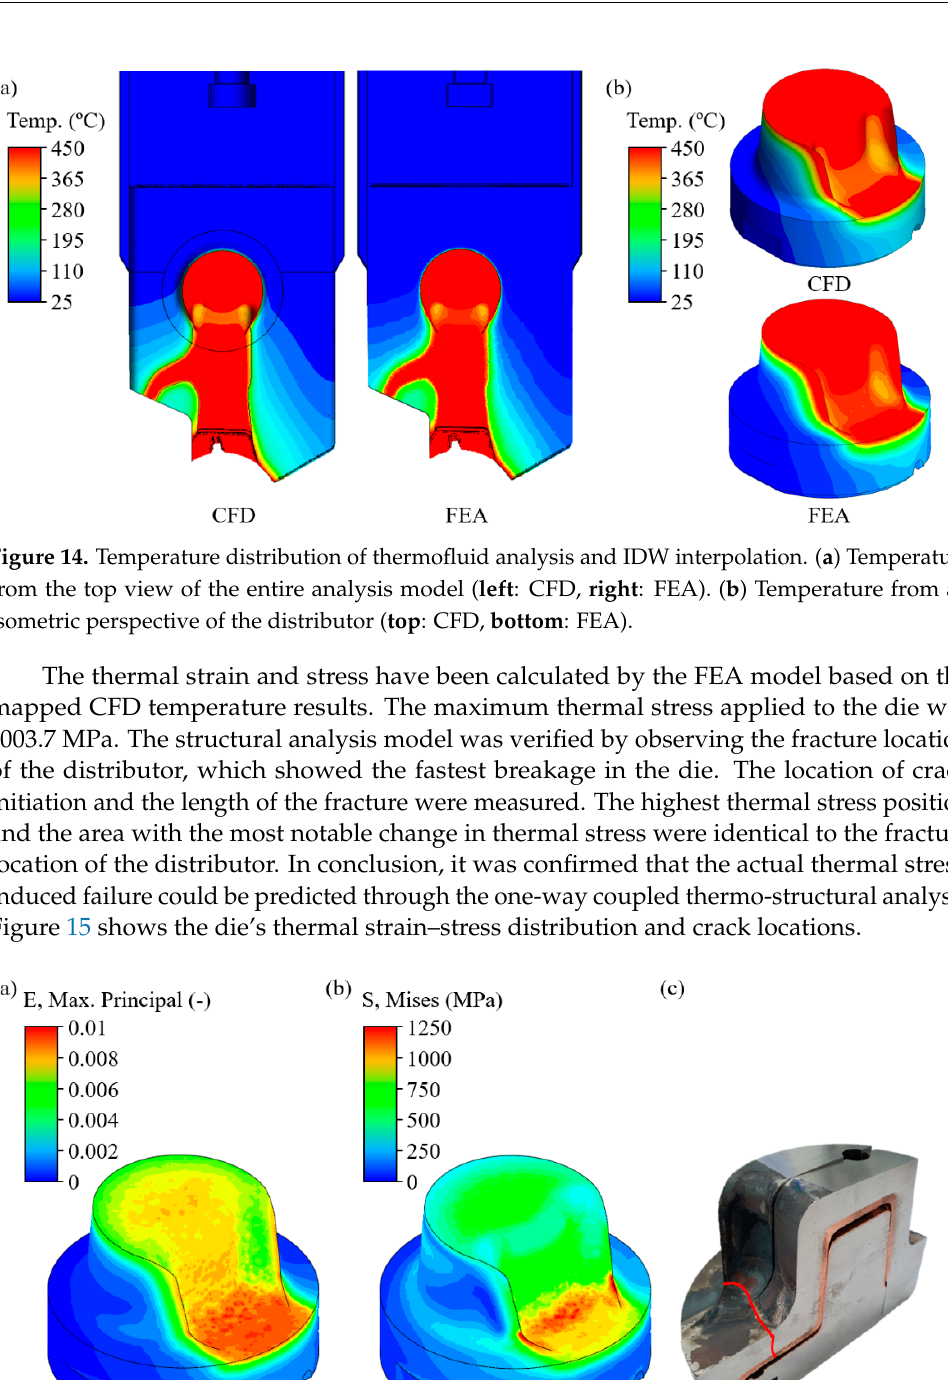
Figure 13. Measured and simulated temperatures on the die during the one-cycle HPDC.